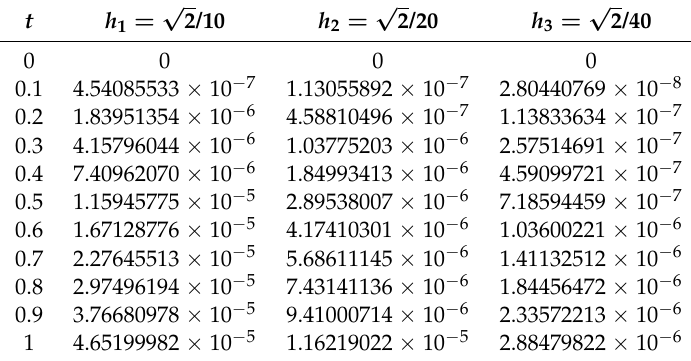
and α = 0.1 for Example 1. 1000